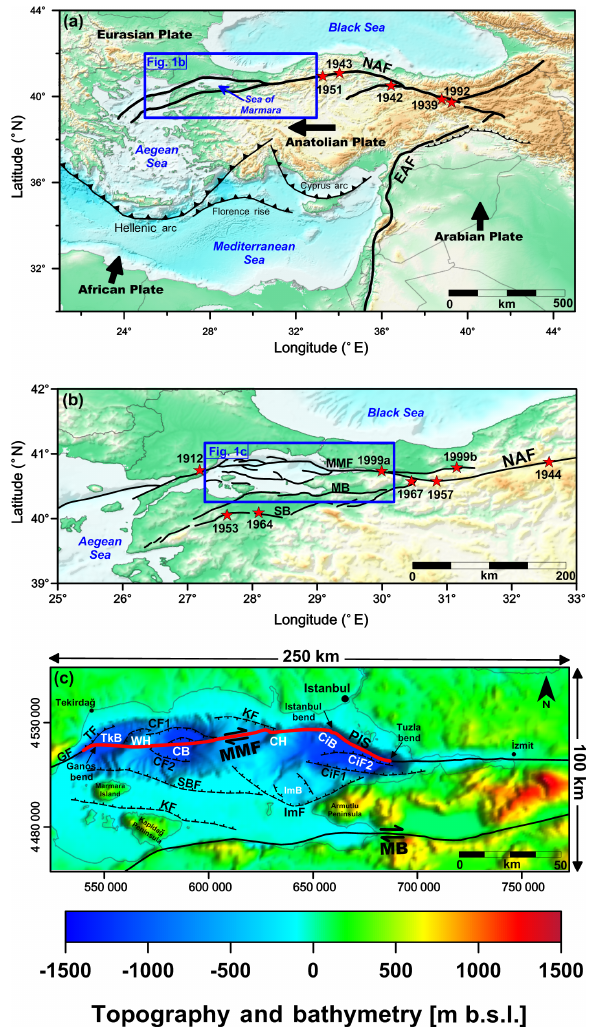
Figure 1. Location and tectonic setting of the model area. (a) Plate tectonic map of the Anatolian Plate and its relation to the Arabian, African, and Eurasian plates. (b) The NAFZ propagation and its branches in the NW Anatolian Plate. (c) The model area (WGS84, UTM zone 35 ◦ N), including the relief map of the Sea of Marmara and its surrounding onshore domain, the seismic gap since 1766 (thick red line; Bohnhoff et al., 2017b), and the fault system identi- fied in the investigations by Armijo et al. (2002, 2005) and Carton et al. (2007). Topography and bathymetry from ETOPO1 (Amante and Eakins, 2009) and Le Pichon et al. (2001). Abbreviations: North Anatolian Fault (NAF), main Marmara fault (MMF), mid- dle branch of NAF (MB), southern branch (SB), Princes’ Islands segment (PIS), Çınarcık basin (CiB), Central basin (CB), Tekirda ˘ g basin (TkB), Imralı basin (ImB), central high (CH), western high (WH), Kapıda˘g fault (KF), southern border fault (SBF), Imralı fault (ImF), Çınarcık faults (CiF 1 & 2), Kumburgaz fault (KF), Central basin faults (CF 1 & 2), Tekirda˘g fault (TF), and Ganos fault (GF). Red stars show the epicenters of major earthquakes ( M > 6 . 5) dur- ing the past